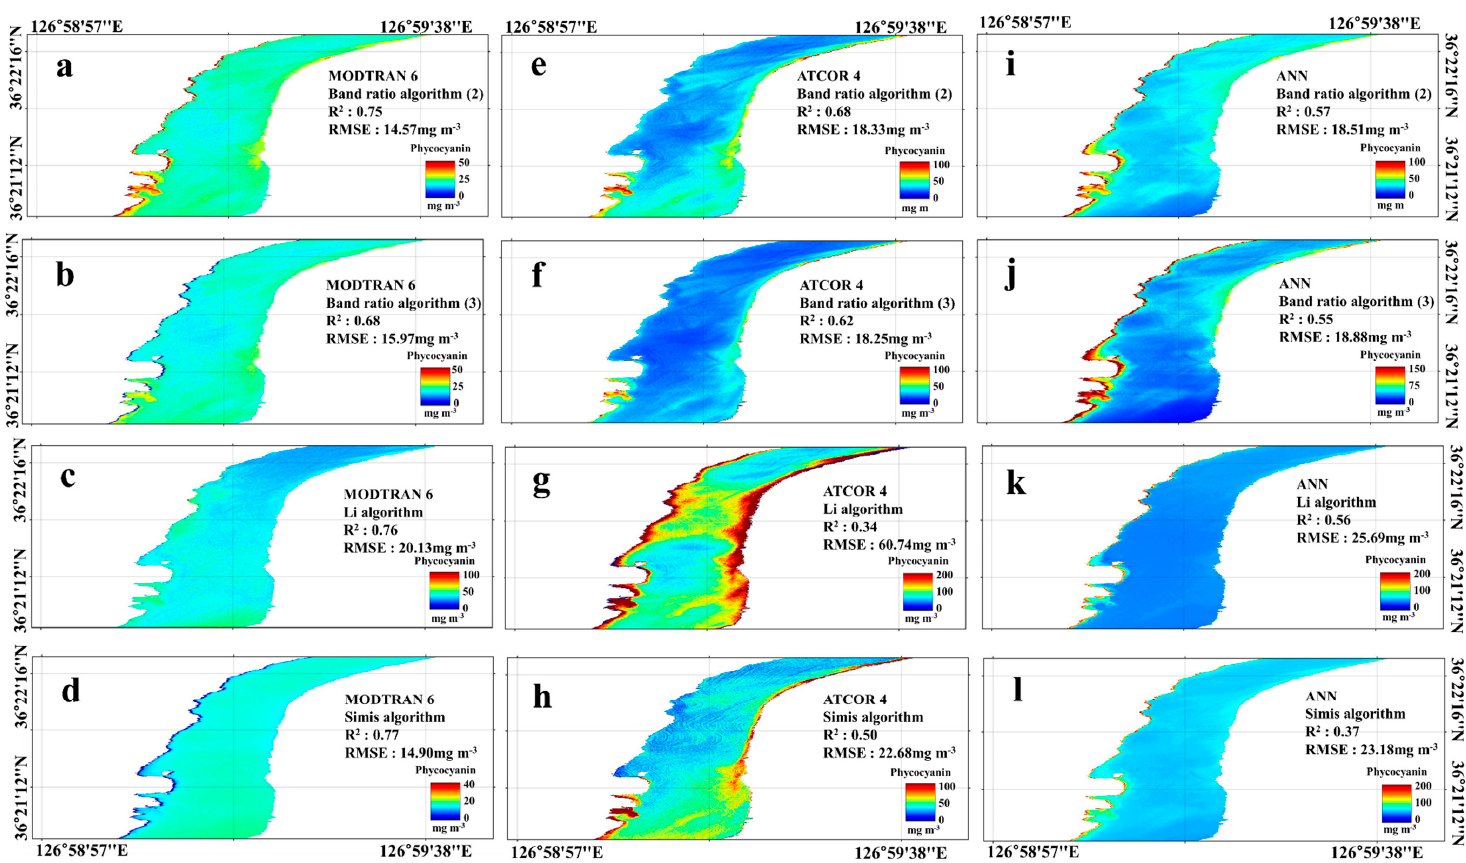
Figure 10. Phycocyanin (PC) concentration images on 24 August 2016 in Section 2. Panels ( a – d ) show the PC distribution driven by the MODTRAN 6 atmospheric correction. Panels ( e – h ) show the PC distribution driven by the ATCOR 4 atmospheric correction. Panels ( i – l ) show the PC distribution driven by the ANN atmospheric correction.